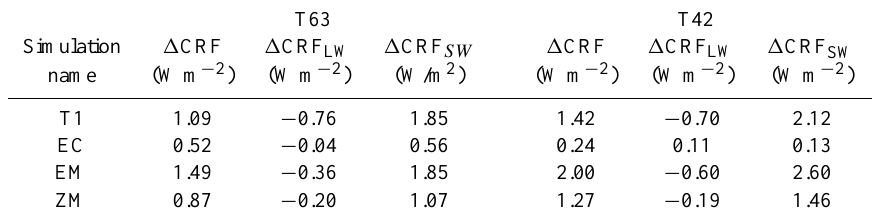
Table 3. Change in globally averaged CRF as well as the change of the long-wave and short-wave CRF component. T63 T42 Simulation 1 CRF 1 CRF LW 1 CRF SW 1 CRF 1 CRF LW 1 CRF SW name (Wm − 2 ) (Wm − 2 ) (W/m 2